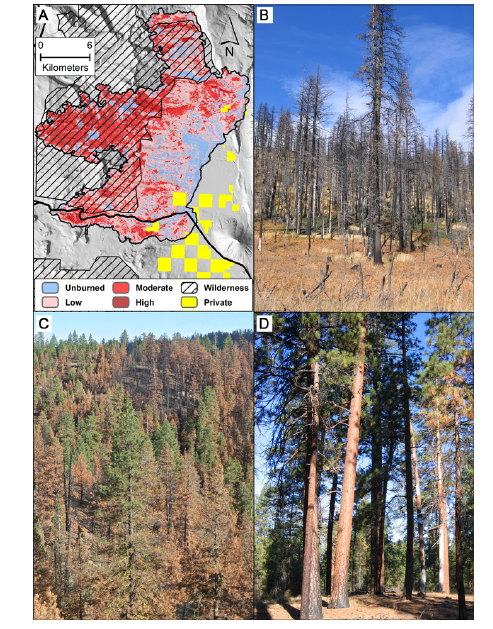
Fig. 3. Patterns of burn severity in the 2003 B & B fire (A), which burned > 36,000 ha on the Deschutes and Willamette National Forests, and images of different burn severities (B–D). (B) High-severity burns destroyed old forest and northern spotted owl ( Strix occidentalis caurina ) habitat but created early successional habitats. (C) Medium-severity and (D) low-severity burns were more characteristic of historical fire severities in the mixed conifer and pine forest types. Images (C) and (D) are from other recent fires in the study area. Severity classes are from U.S. Department of Agriculture Forest Service and U.S. Geological Survey